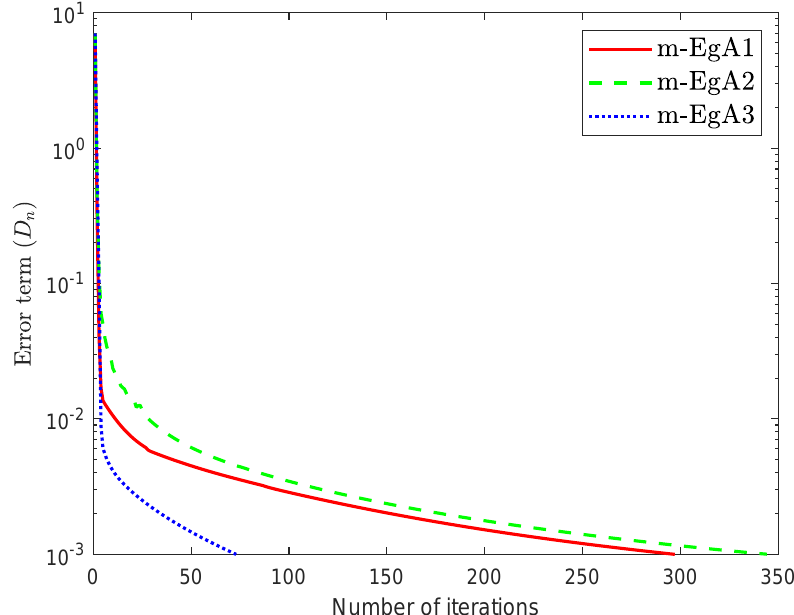
Figure 7. Numerical behaviour of Algorithm 1 compared to Algorithm 1 in [30] and Algorithm 2 in [30] for Example 1, when m = 50.